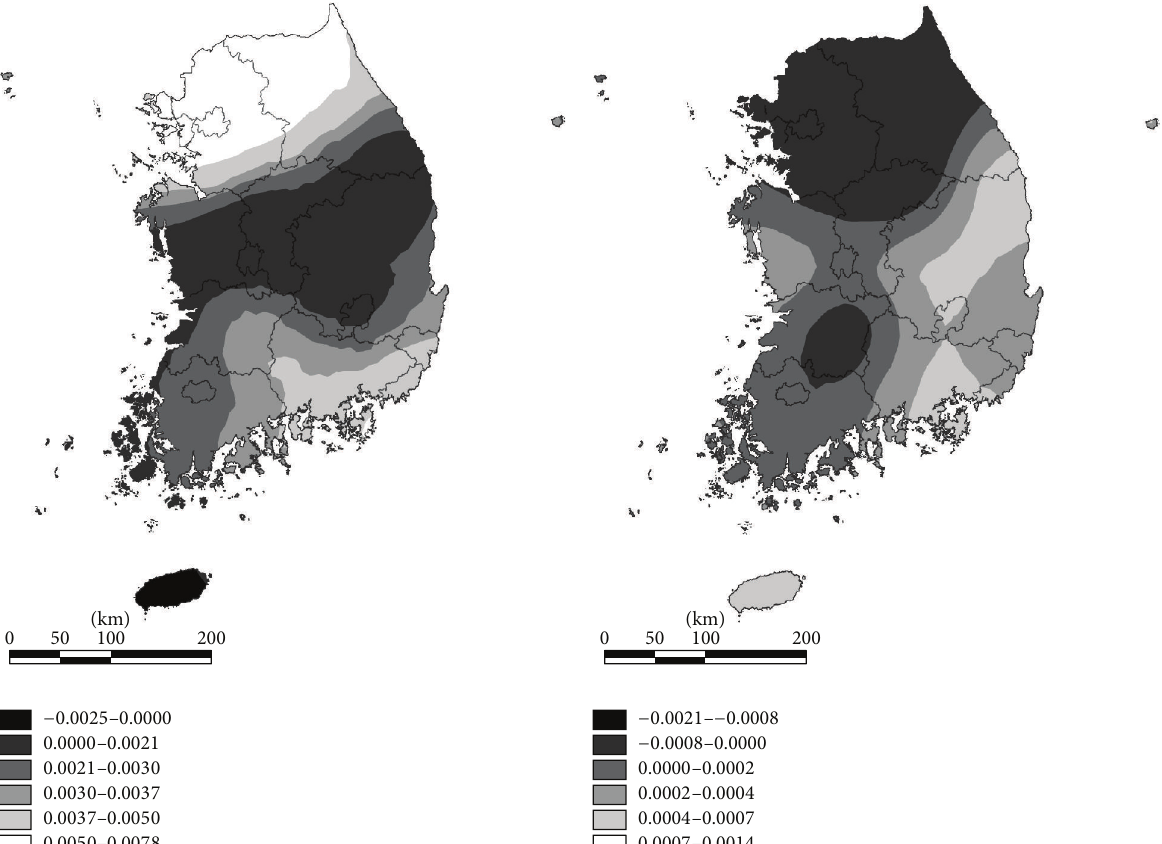
Figure 7: Map of the linear trend of 1-hour precipitation statistics of